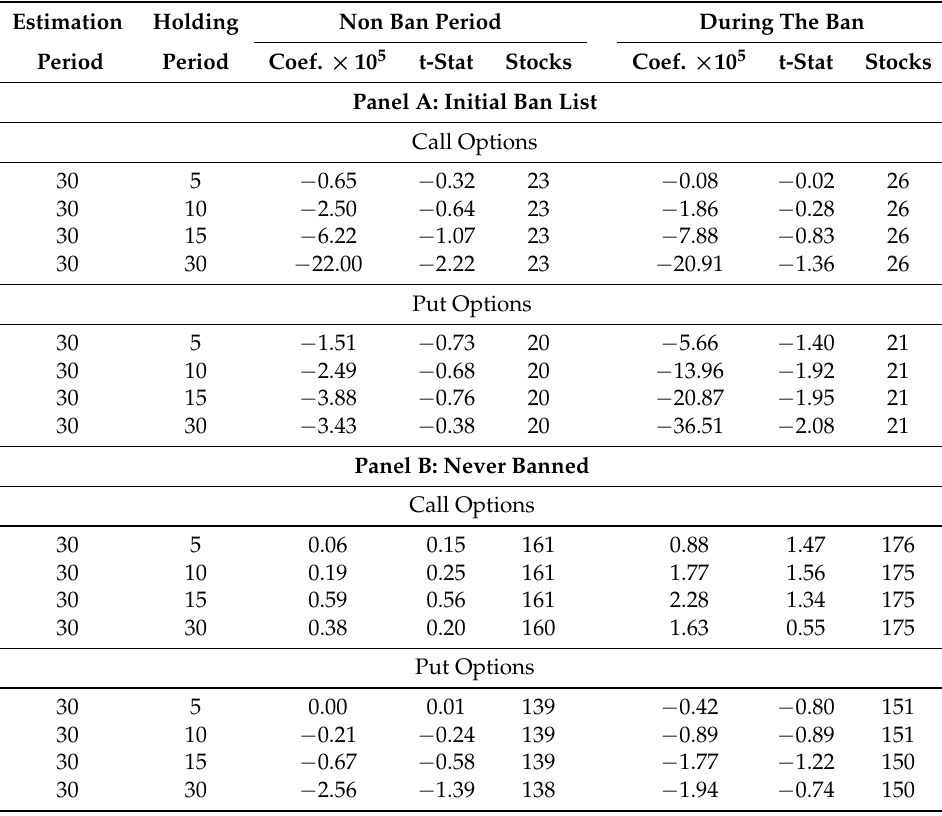
Table 7. Information in option trading volume for underlying stock